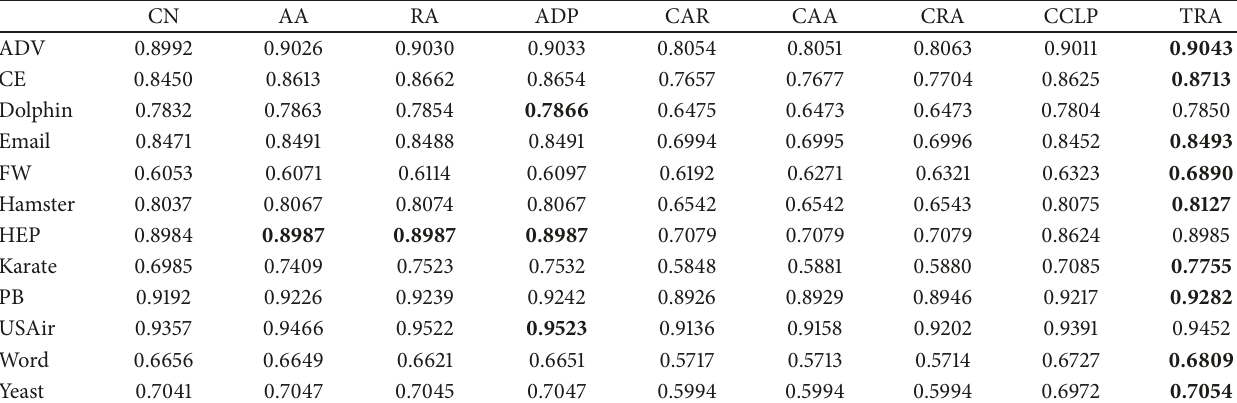
Table 3: The AUC of different methods in 12 networks. The results are the average of 50 independent implementations with |𝐸 𝑡𝑠 |/|𝐸| = 0.1 . The best performance for each network is emphasized by boldface.